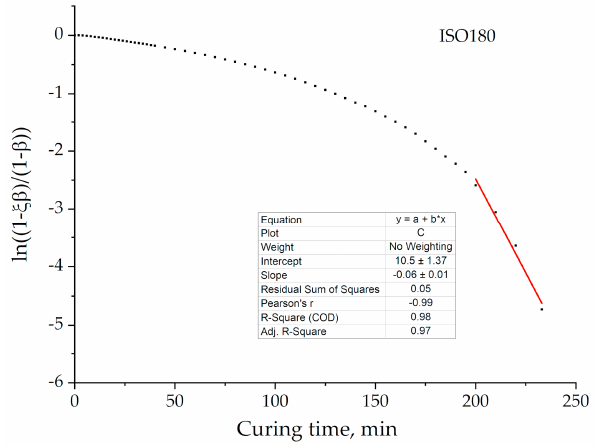
Figure 10. A graphical representation of the curing process in coordinates of the 1-order kinetic equation with self-retardation for formulation 2 at an isotherm of 180 ° C, where the red line is the linear fitting and black dots are experimental data.